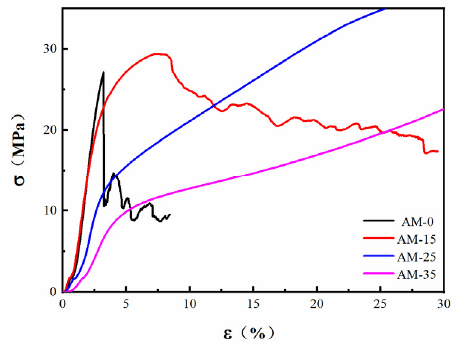
Figure 14. Uniaxial compressive stress–strain curves of the 28 d specimen.